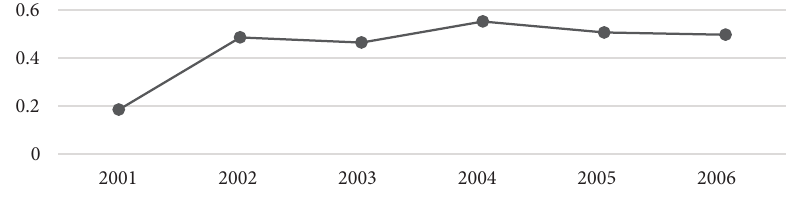
Figure 2. Economic decisions rationality index during 2001–2006 (source: authors’